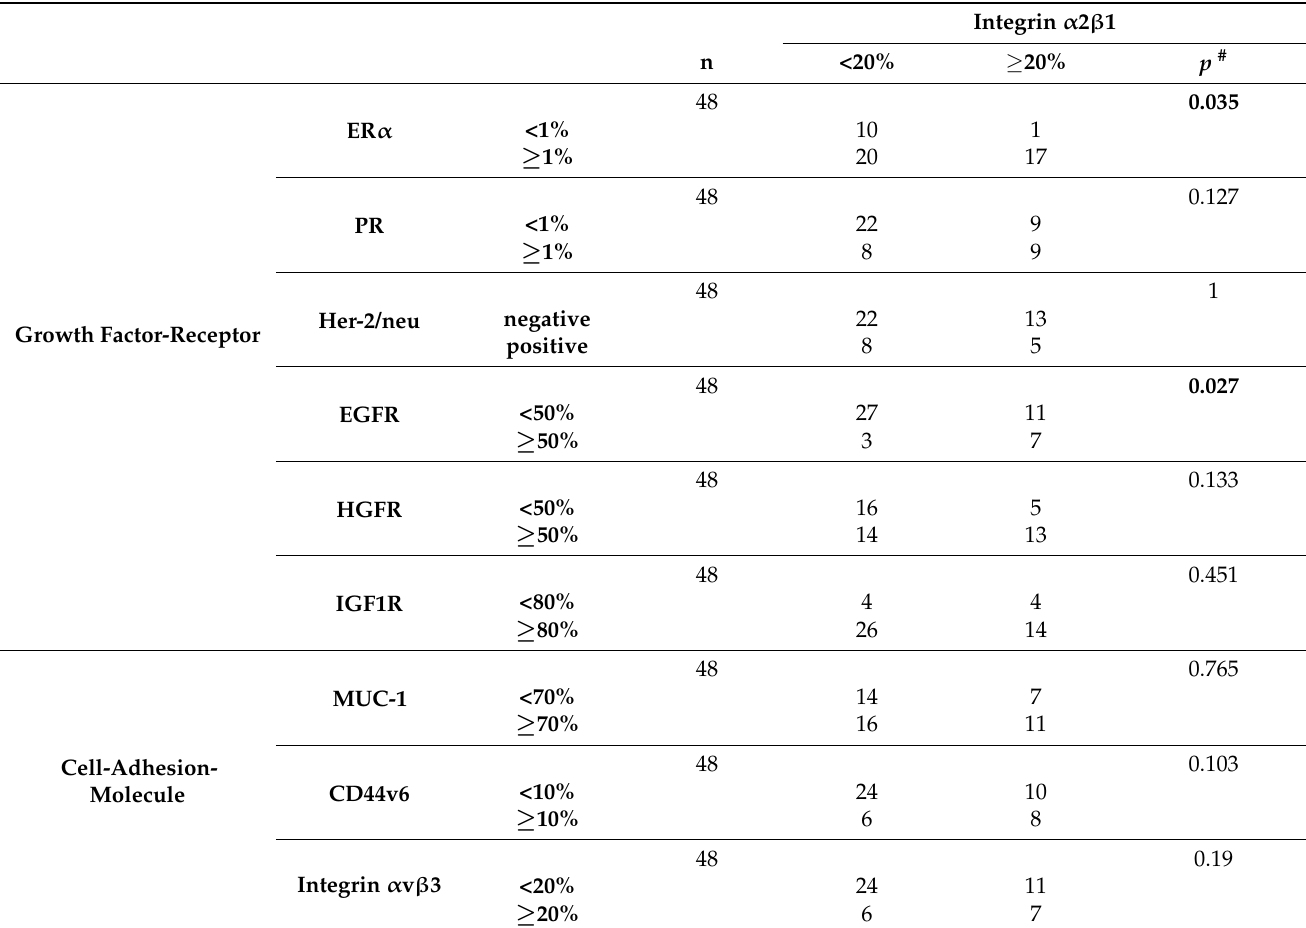
Table 4. Correlation between integrin α 2 β 1 and other